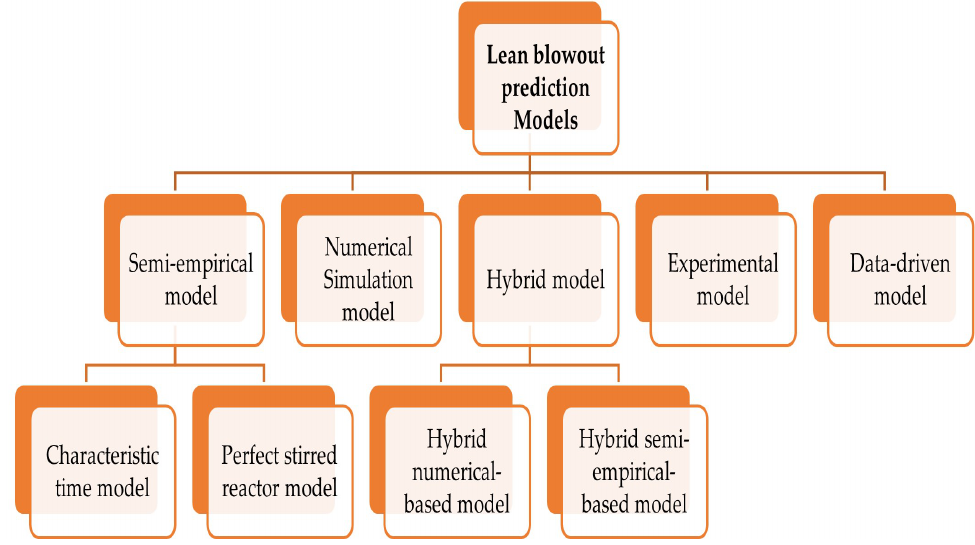
Figure 1. Diagram of the techniques used for LBO